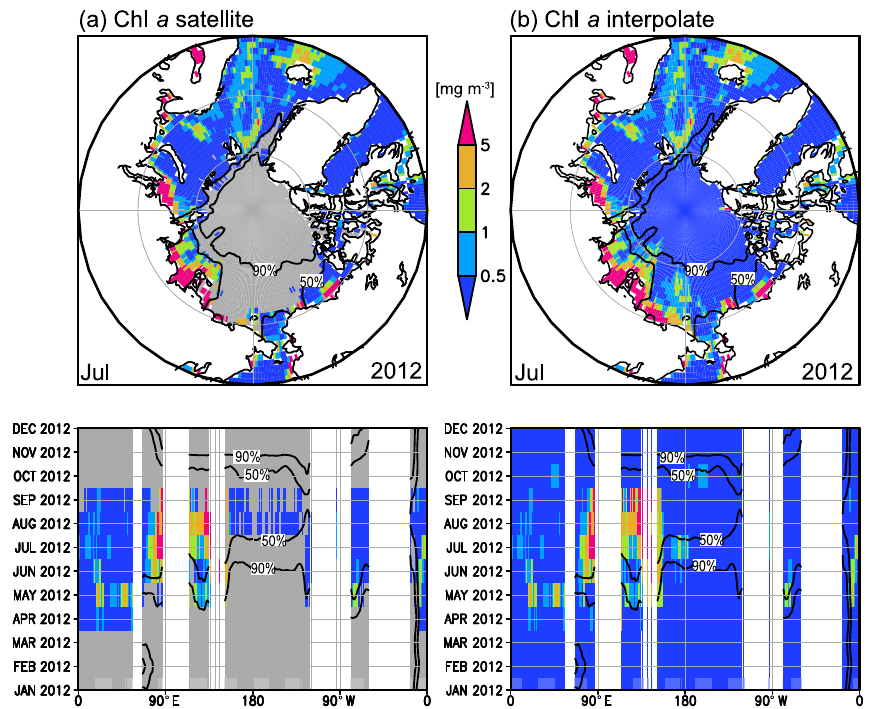
Figure 3. (a) Original and (b) interpolated Chl a (mgm − 3 ) in July 2012 (upper panels), and along 75 ◦ N in 2012 (lower panels). Black lines denote SIC of 50 and 90%. Gray areas in (a) indicate missing Chl a